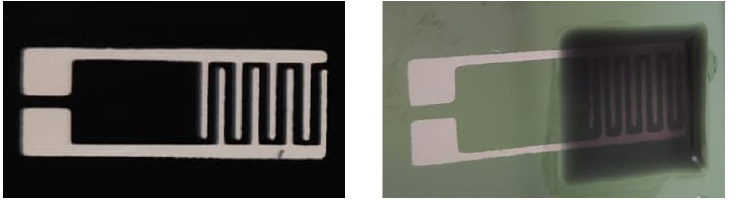
Figure 13. Screen-printed interdigital electrodes (left). CNT-PDMS composite mold-printed on top of electrodes (right). For clarification purposes a 0.2 CNT wt% solution was printed in order to leave the electrodes visible through the layer.